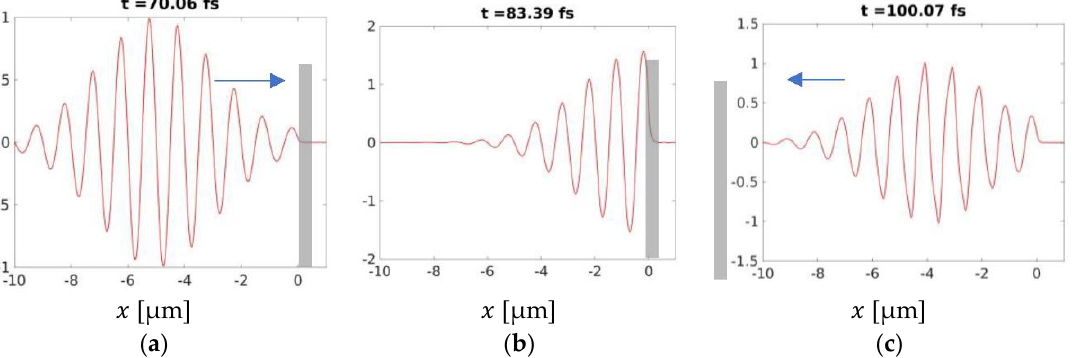
Figure 2. The evolution of the laser transverse electric field, 𝐸 𝑦 , upon interaction with an overdense foil. The field is normalized to the Tajima-Dawson field, 𝐸 𝑇𝐷 = 𝑚 𝑒 𝑐𝜔 𝐿 /𝑒, where 𝜔 𝐿 is the laser frequency. The laser pulse is reflected and thus minimizing the interaction with the foil and subsequently the conversion efficiency is 0.5%. Laser pulse is injected from the left boundary and at t = 70.06 fs arrives at the foil ( a ), the maximum intensity reaches foil at t = 83.39 fs with the field penetration exhibiting exponential decay into the foil up to a few the skin depth lengths ( b ). Reflected laser pulse shape is slightly modified travelling to the left boundary ( c ).